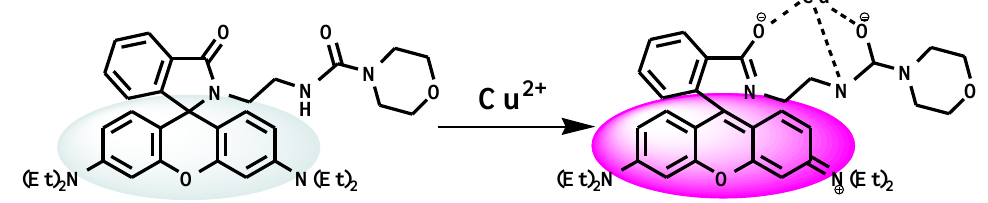
Figure 8. Proposed binding mode and Cu 2+ sensing mechanism of RECM.